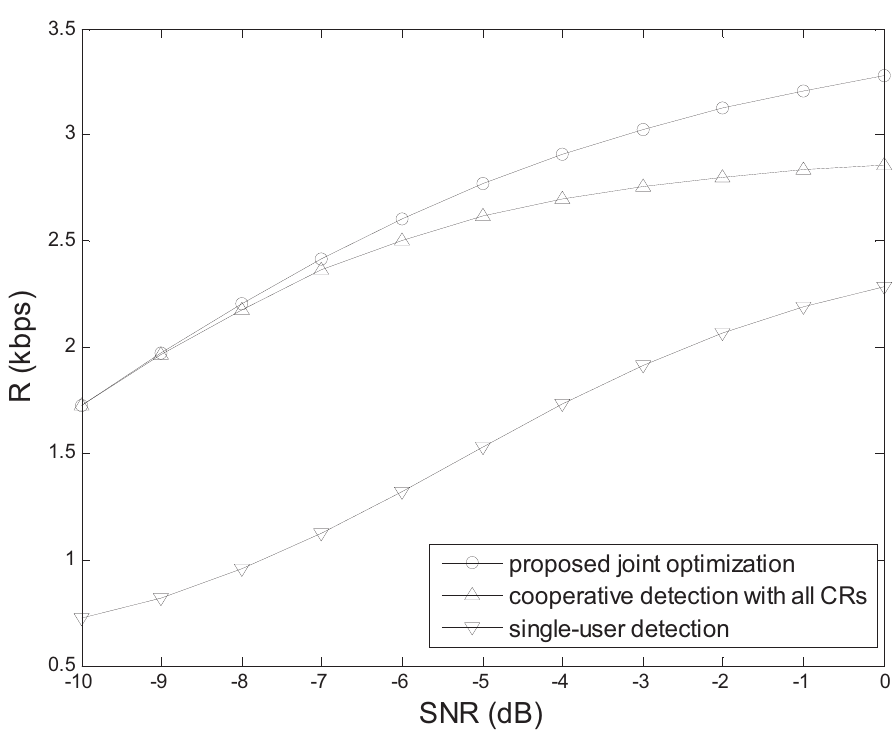
Figure 10. Average throughput vs. SNR.